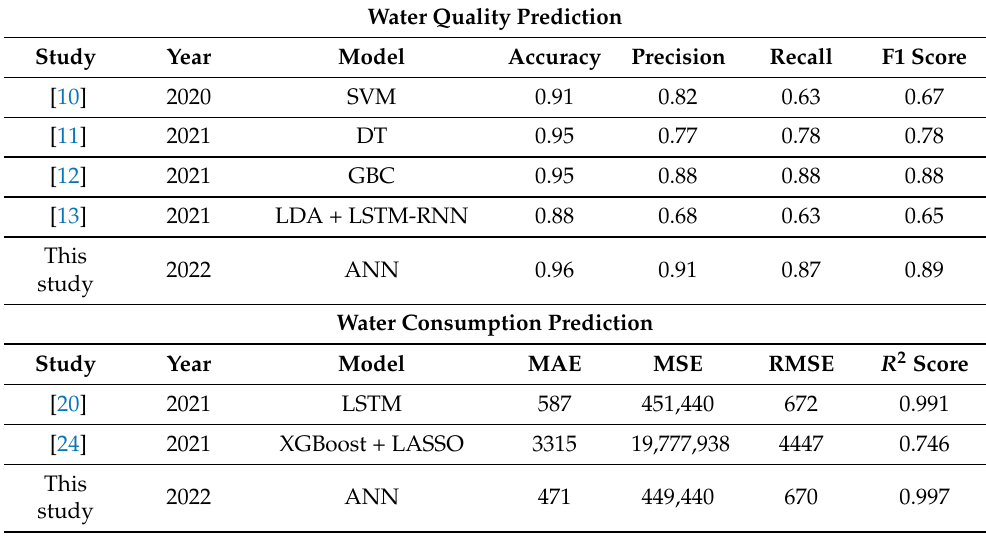
Table 14. Performance comparison with existing approaches.